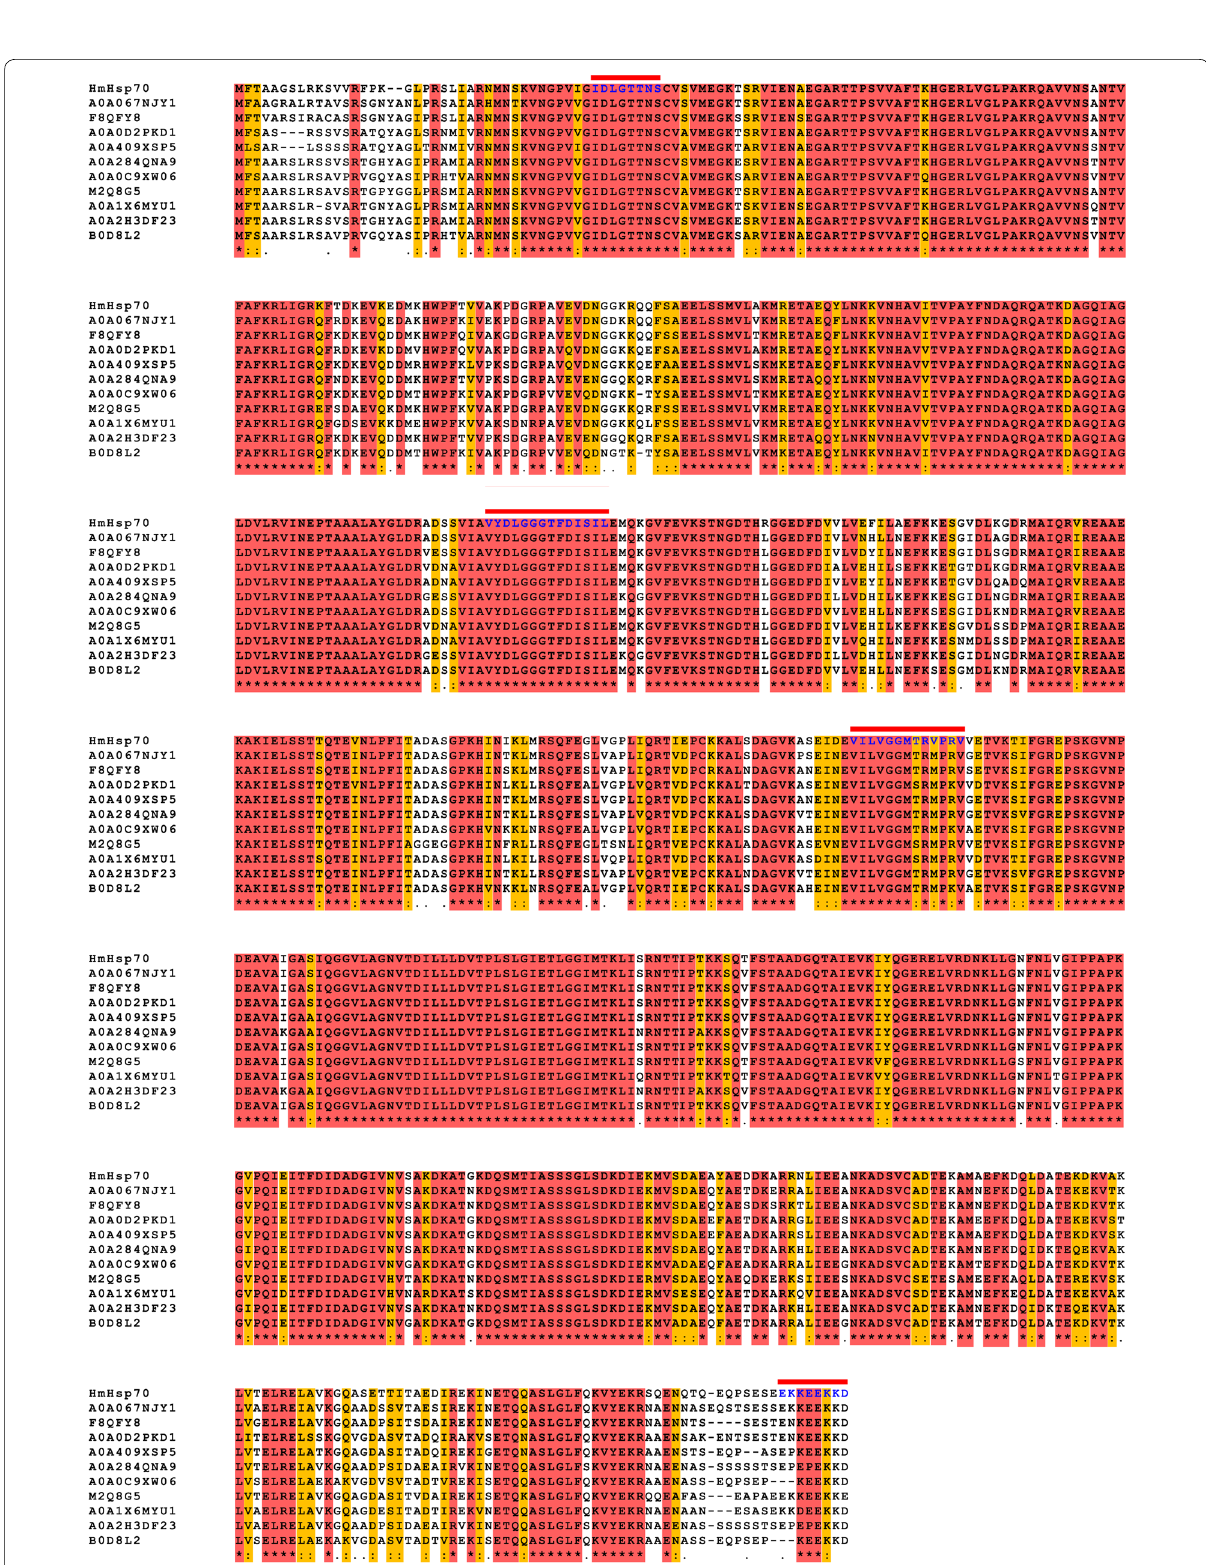
Fig. 1 Alignments of the deduced amino acid sequences of HmHsp70 and 10 relative Hsp70 proteins from basidiomycetes fungi. Hsp70 family signature sequences are indicated with bars above the